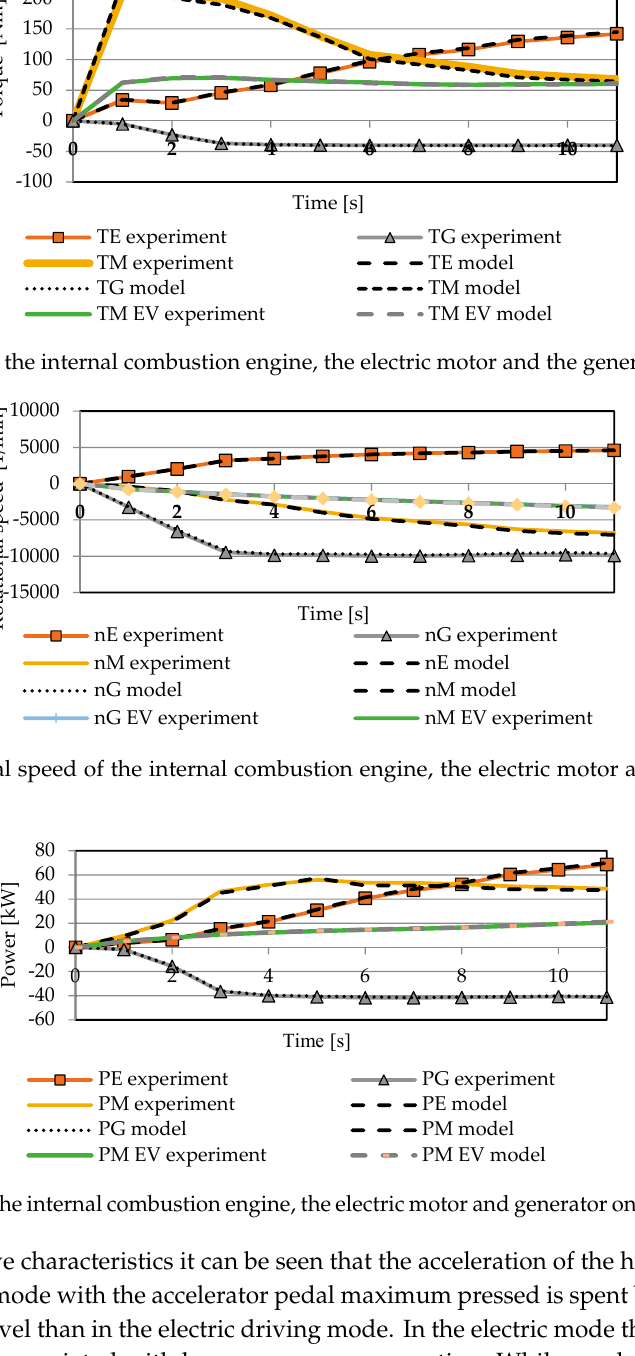
Figure 4. Level of the traction battery charge and vehicle speed versus time.